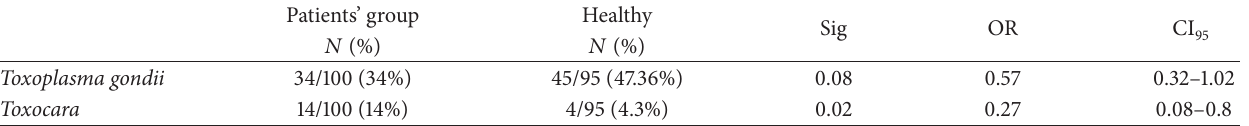
Table 2: Seropositivity of Toxoplasma gondii and Toxocara antibodies in patients with schizophrenia disorder and healthy controls.